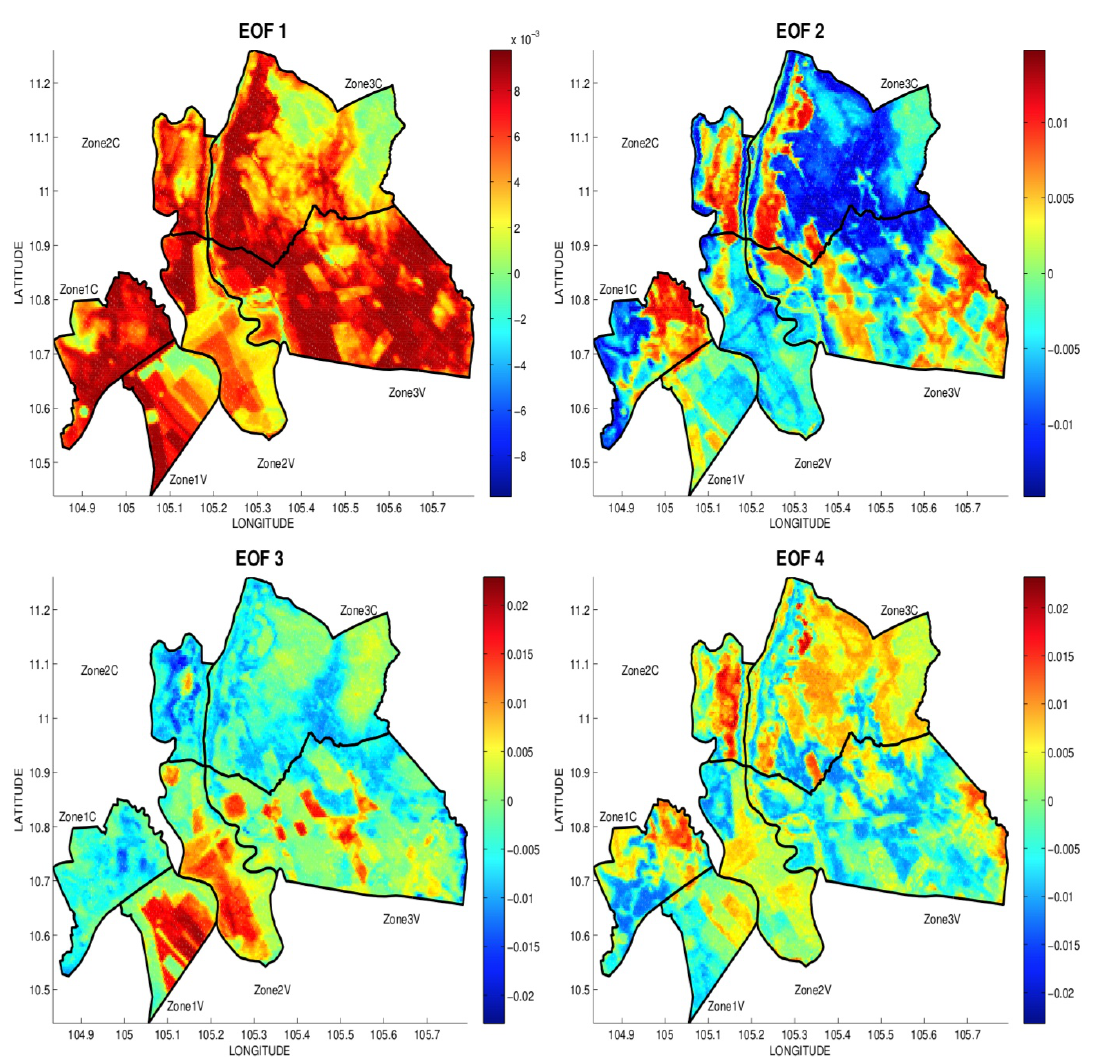
Figure 6. The first four spatial Empirical Orthogonal Functions (EOFs) of the MODIS inundation estimates associated to the temporal base functions of Figure